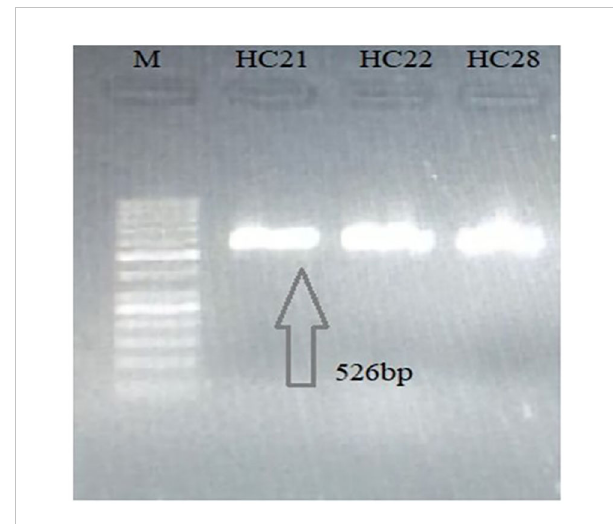
FIGURE 3 Agarose gel (2%) of Echinococcus multilocularis Cyt-b gene PCR- ampli fi ed product. M, 50-bp molecular ladder; H, human cyst (the gels are cropped).